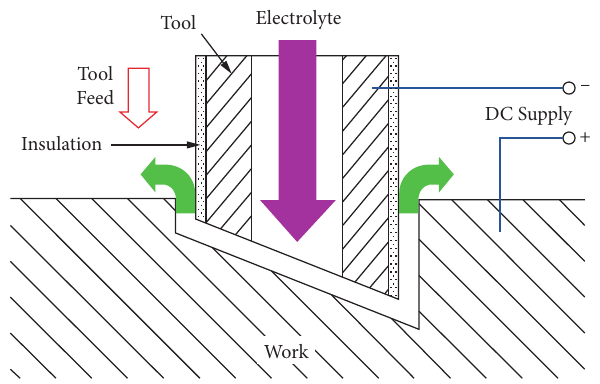
Figure 1: Electrochemical machine